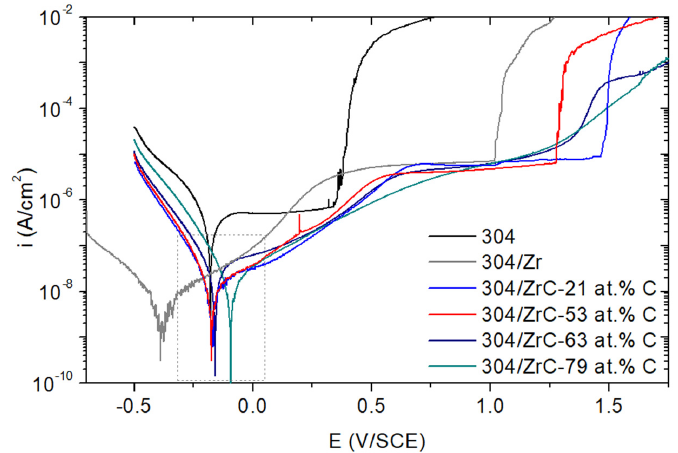
Table 6. Electrochemical parameters characterizing corrosion processes of 304L steel substrate, bare and coated, in Fusayama-Meyer’s artificial saliva. Sample